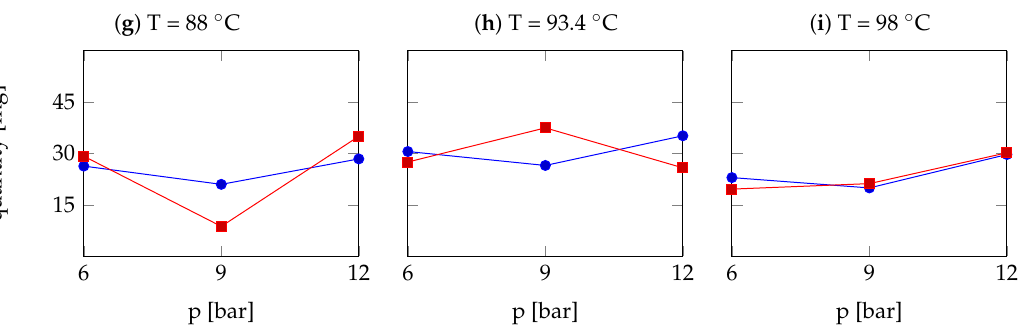
Figure 18. Comparison between the lipids extracted through numerical simulations (blue profile with circles) and laboratory measurements (red profile with squares), with different inlet water temperatures and pressures and different grain size of Robusta coffee powder. Figures ( a – c ) show the results of optimal granulometry, Figures ( d – f ) of coarse granulometry and Figures ( g – i ) of fine granulometry.